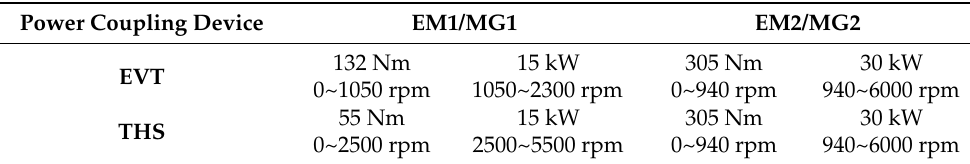
Table 2. Design parameters of CSPM and THS. Figure 5. External characteristic curves of MG1 and MG2 in the THS.